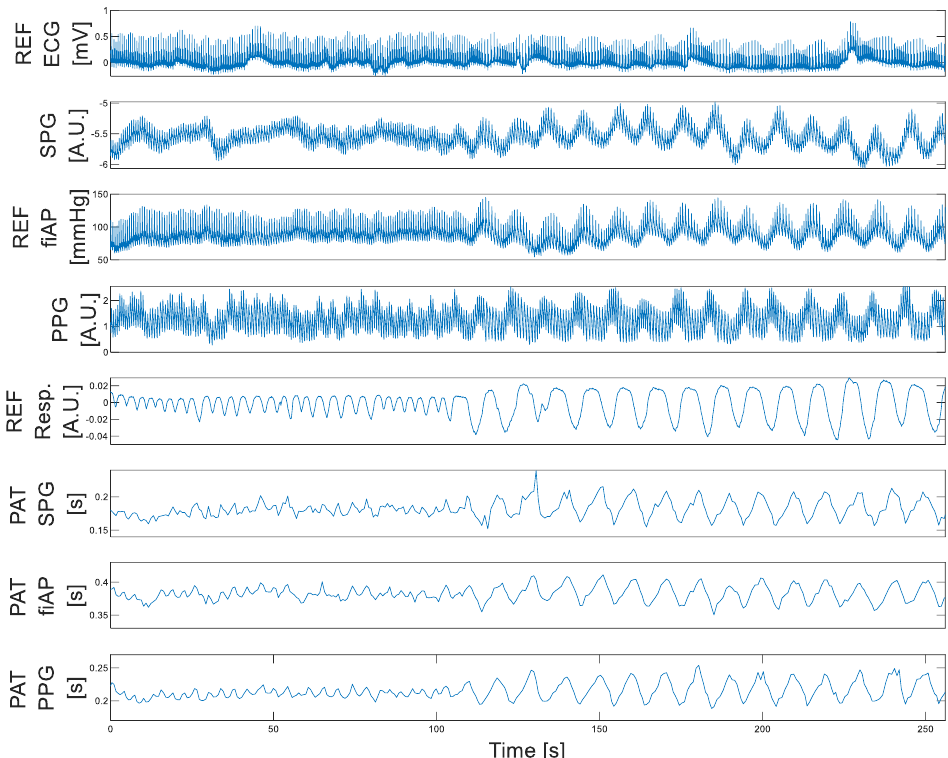
Figure 4. Spontaneous versus paced breathing. Example of signals collected from subject 1. Paced breathing starts at ~105 s. Parameters from top to bottom: ECG, SPG, fiAP, PPG, Respiration, PAT SPG, PAT fiAP and PAT PPG. Note: Time base was chosen to highlight amplitude modulation and correlation of PAT (across > 250 heartbeats). Individual heartbeats appear as spikes, modulated in the respiration rhythm. For SPG, PPG and ECG at a faster time base, see Figure 3.